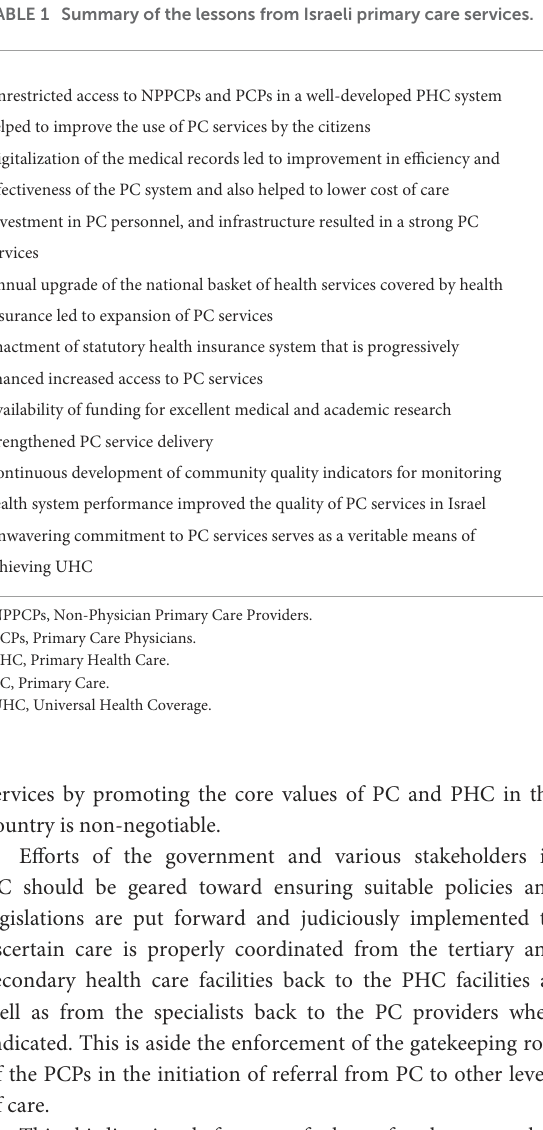
TABLE 1 Summary of the lessons from Israeli primary care